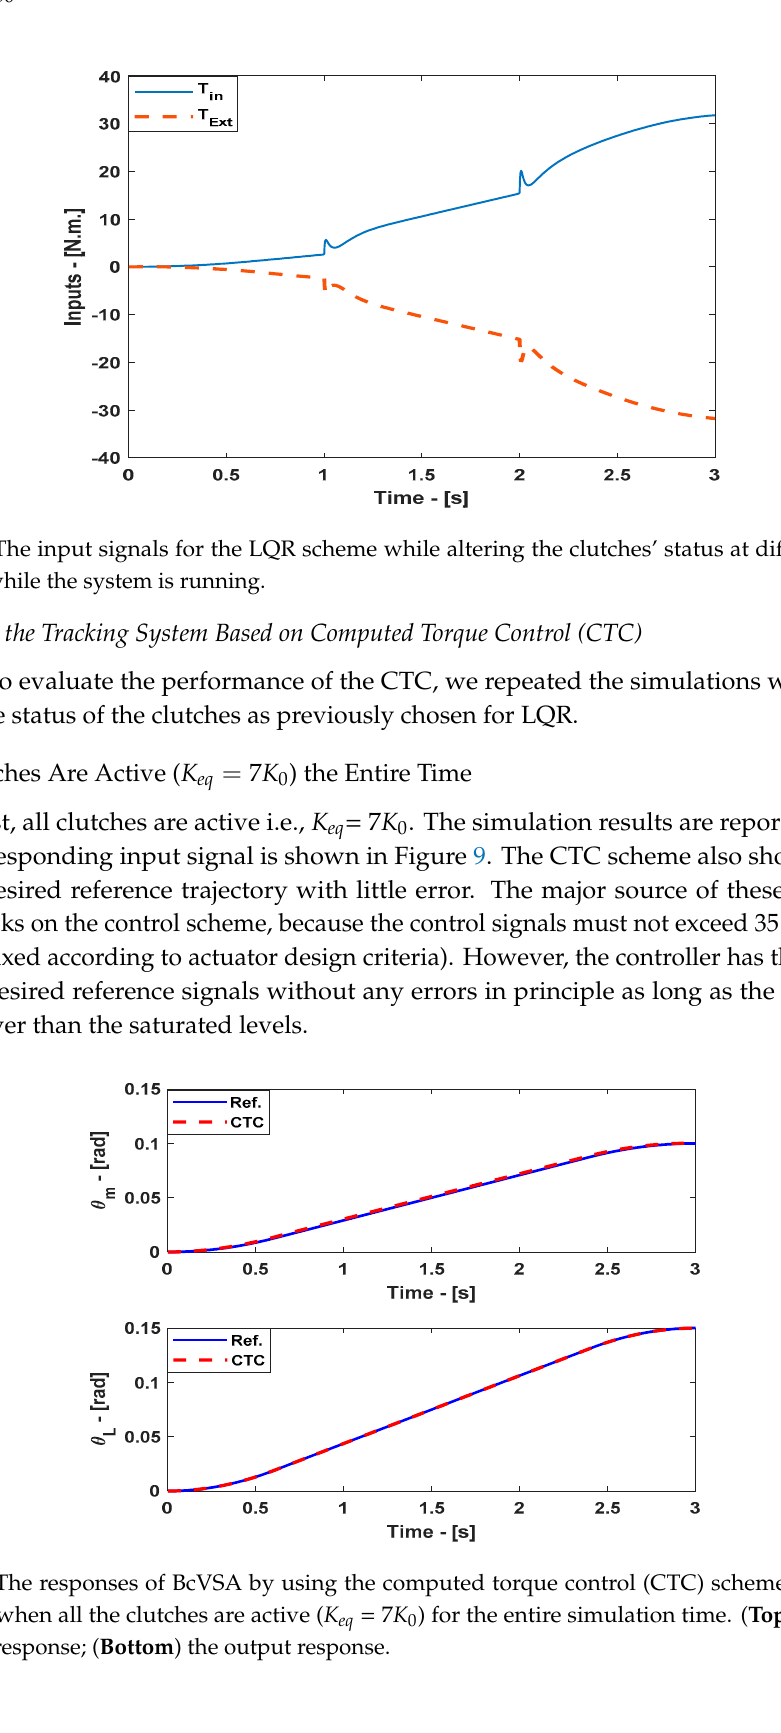
Figure 6. The responses of DVSA based on the LQR scheme in the scenario of altering the status of clutches while the system is running. ( Top ) the input trajectory response; ( Bottom ) the output re- sponse.